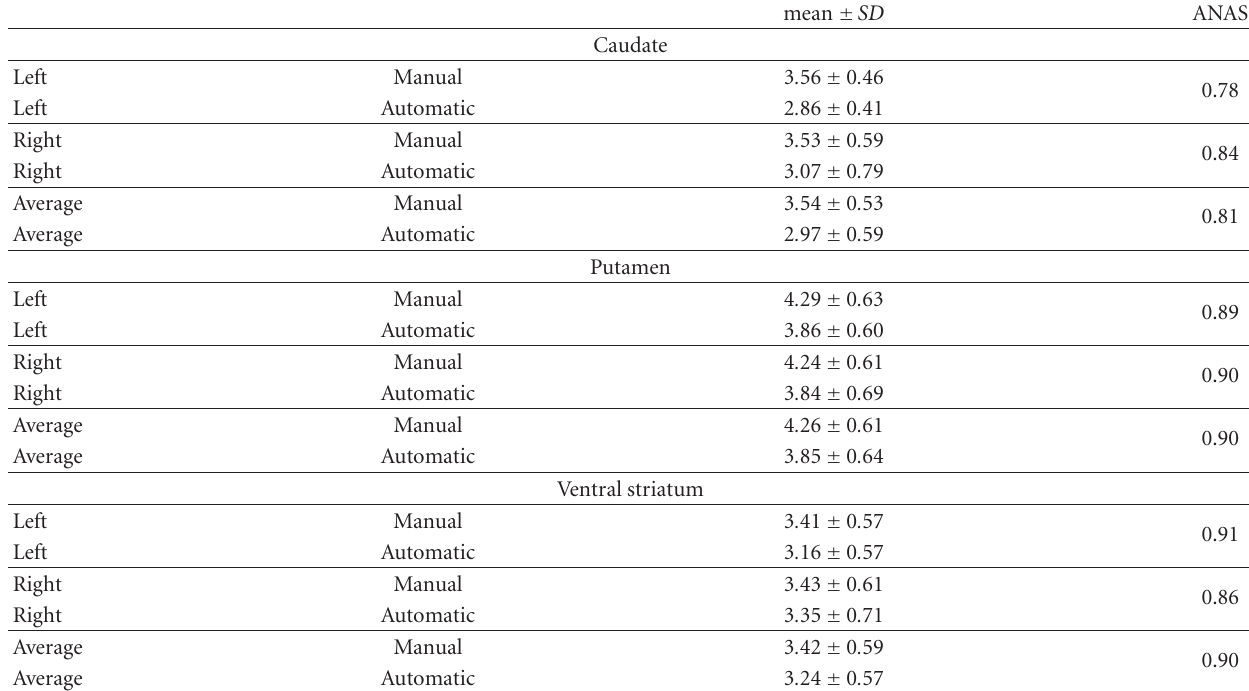
Table 2: BP ND and ANAS values obtained from the average of the HRRT PET data. These measurements allow the similarity analysis between the automatic and manual